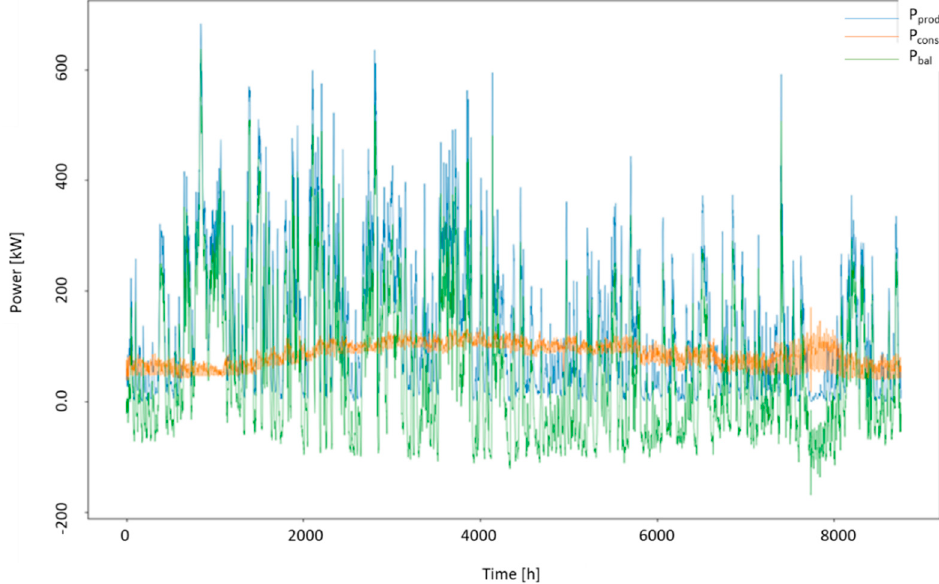
Figure 7. Power production, Power consumption and difference between the two (Power balance), in KW for 2016, 4 Weptos configuration.